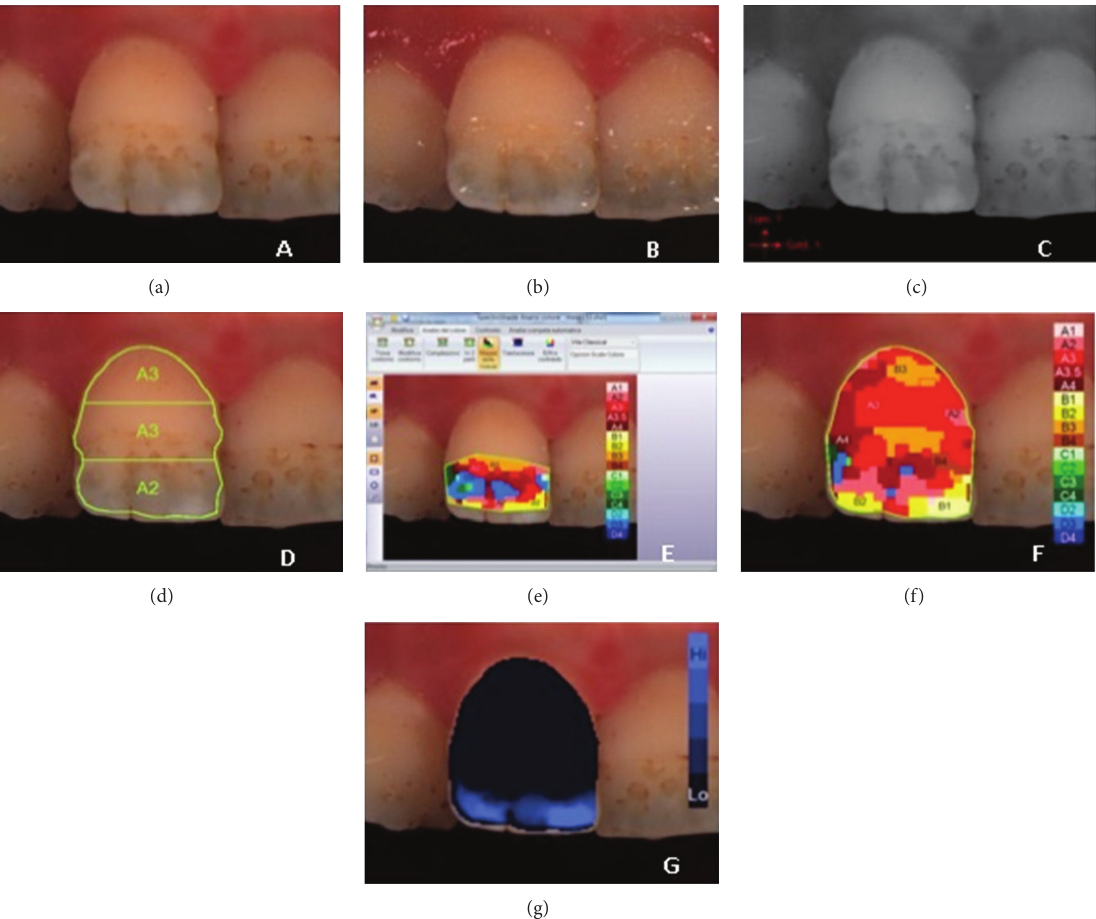
Figure 4: Example of 𝐿 ∗ 𝑎 ∗ 𝑏 ∗ measurements of hypoplastic defects on upper central incisor: (a) polarized image; (b) gloss mode allowing the identification of “pure enamel zones”; (c) contrast image; (d) evaluation of the three equal zones along the median axis: gingival, central, and incisal; (e) colour distribution and detailed mapping of the defect surface; (f) overall detailed mapping; (g)